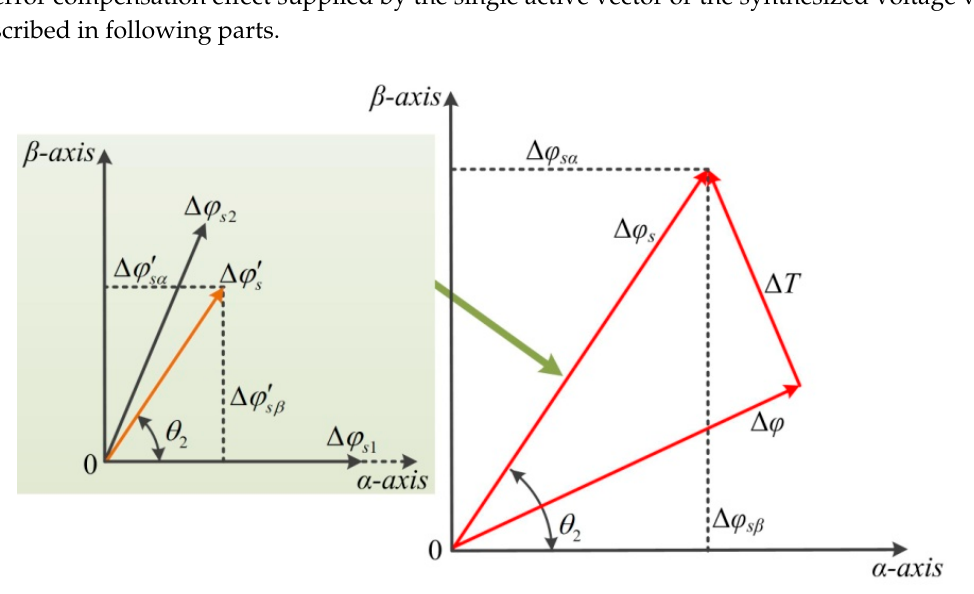
Figure 7. Analysis of error compensational effects in dynamic-state.